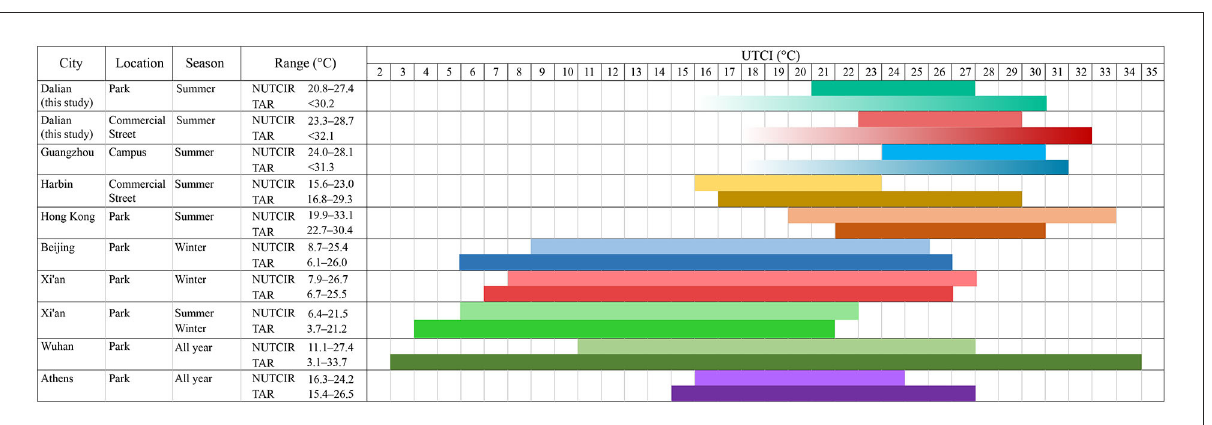
FIGURE11 Relationship between NUTCIR and